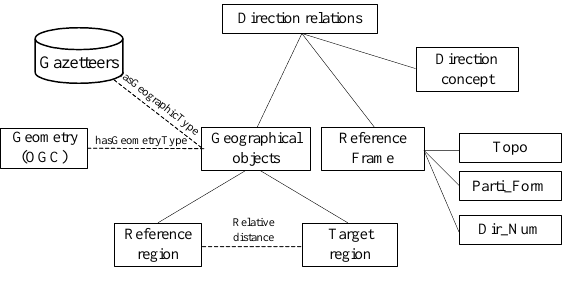
Figure 1. The implementation of conceptual